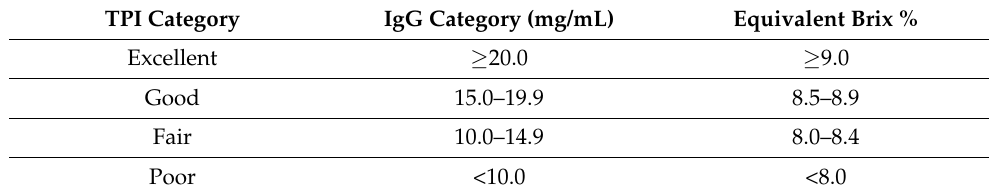
Table 1. Transfer of passive immunity (TPI)